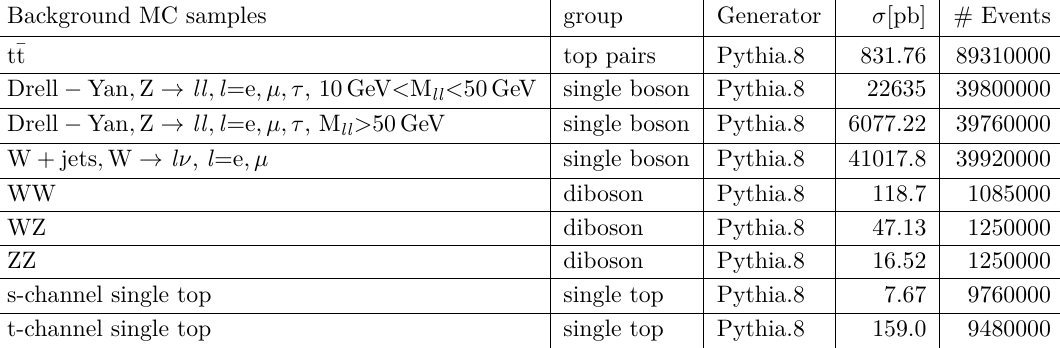
Table 1 . Simulated samples of the background processes with their corresponding cross section and produced event numbers.